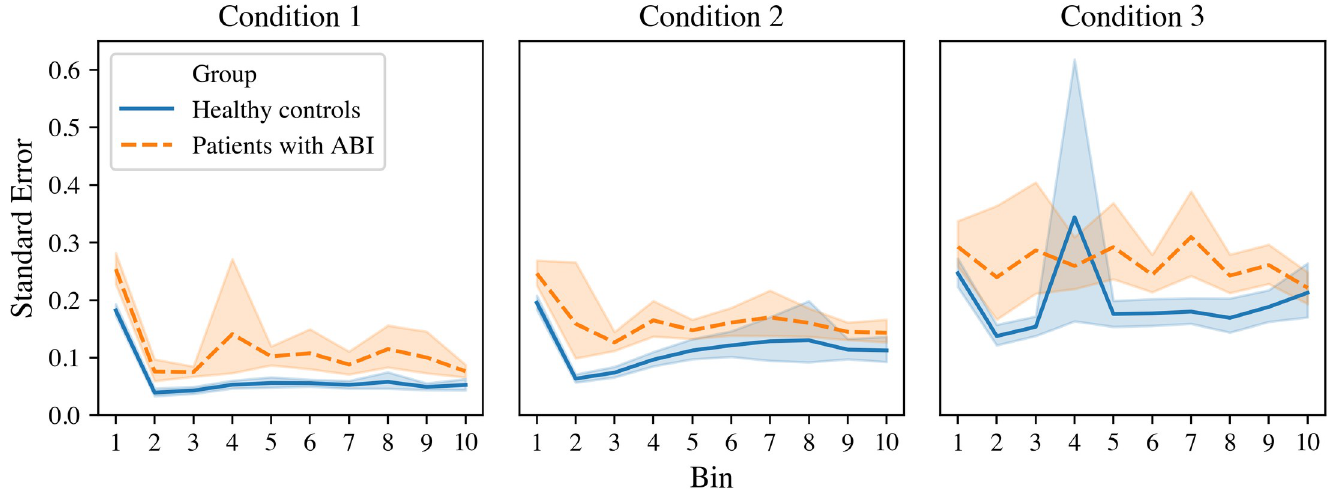
Fig 4. Performance stability in naming speed (with time between responses as outcome measure) on the Stroop (condition 1, 2 and 3) at group level. Each condition was divided into 10 bins of 10 words (horizontal axis). The standard error is depicted on the horizontal axis. Patients fluctuated significantly more in naming speed compared to healthy controls.